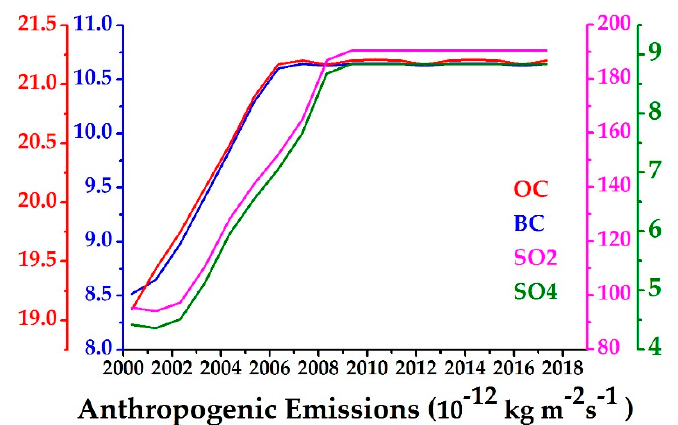
Figure A1. Anthropogenic emissions of organic carbon (OC), black carbon (BC), SO 2 and SO 4 derived from the MERRA-2 aerosol reanalysis datasets (https://disc.gsfc.nasa.gov/daac-bin/FTPSubset2.pl?LOOKUPID_List=M2I3NXGAS) over the YRB since 2000.